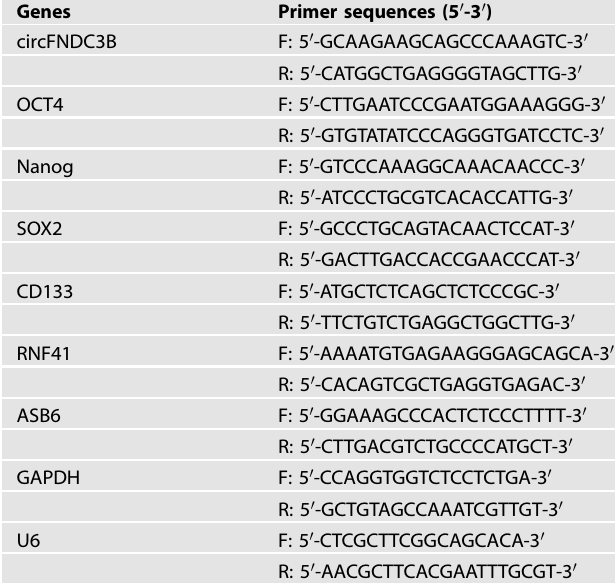
Table 1. Primers used for qRT-PCR